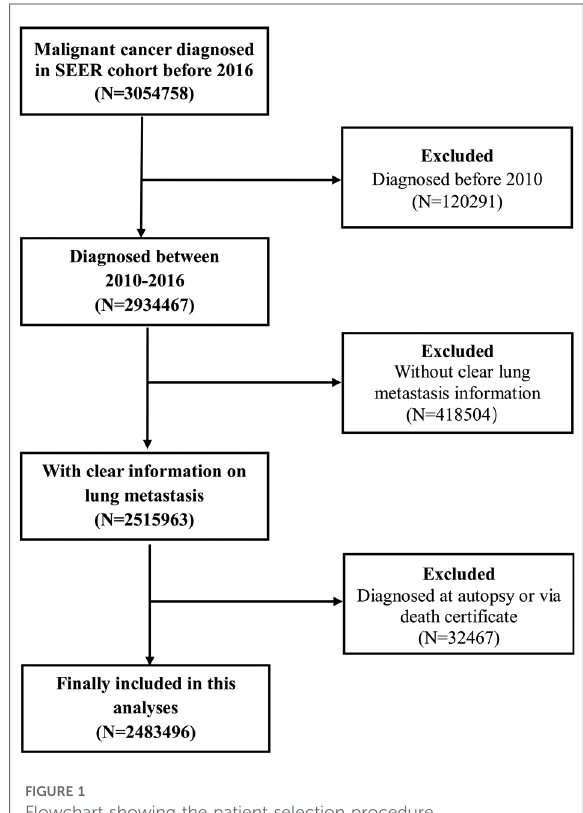
FIGURE 1 Flowchart showing the patient selection